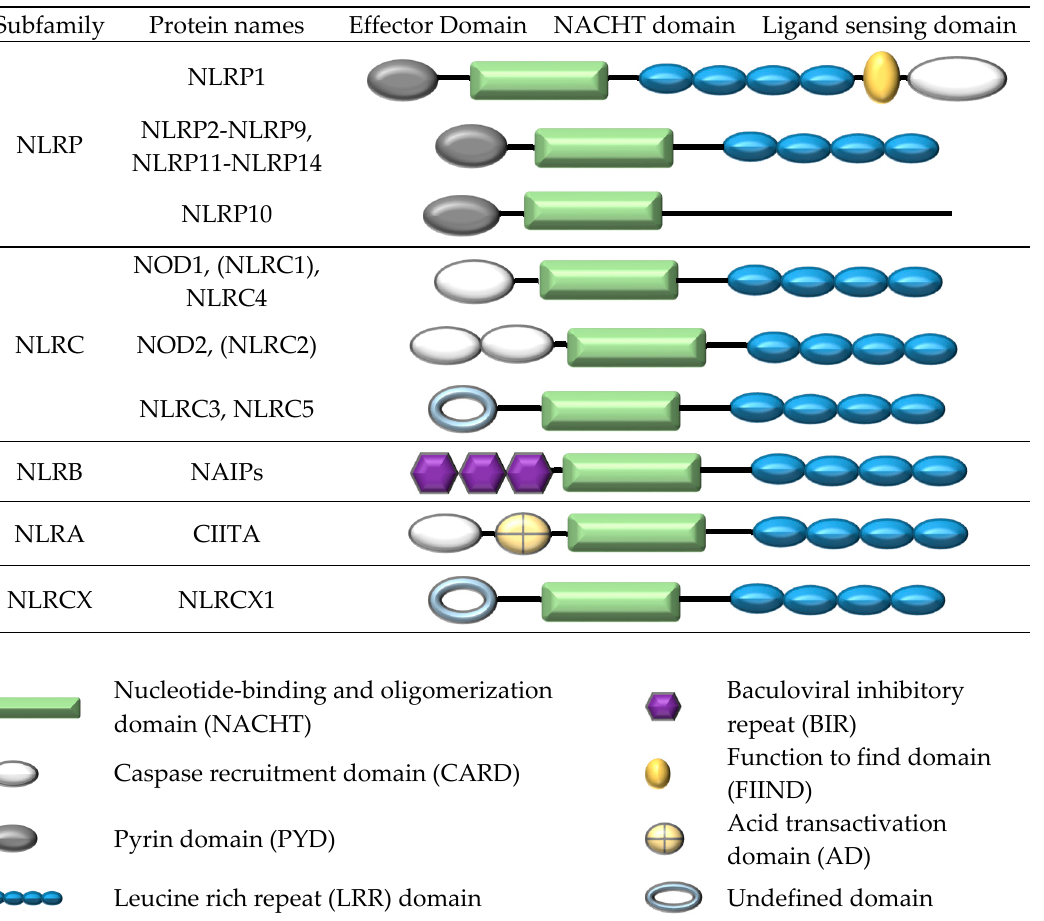
Figure 1. Structure of the human nucleotide-binding oligomerization domain (NOD)-like receptor subgroups.